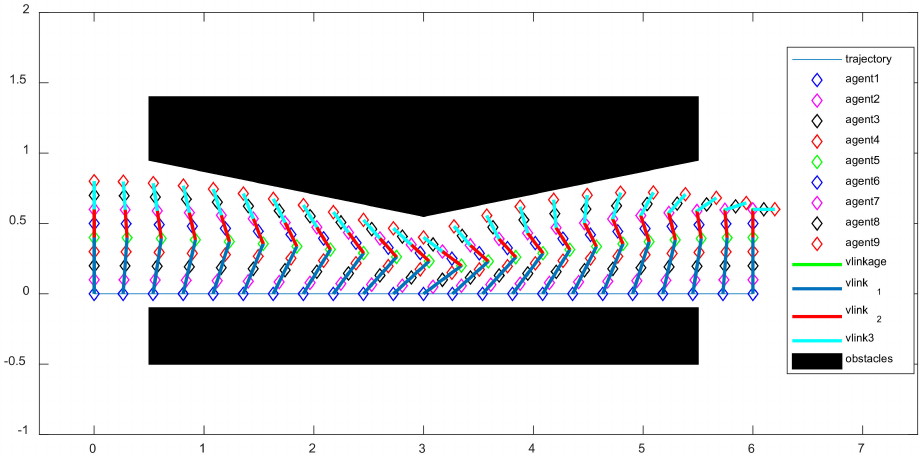
Figure 23. Formation reconfiguration using a virtual linkage with three virtual links.